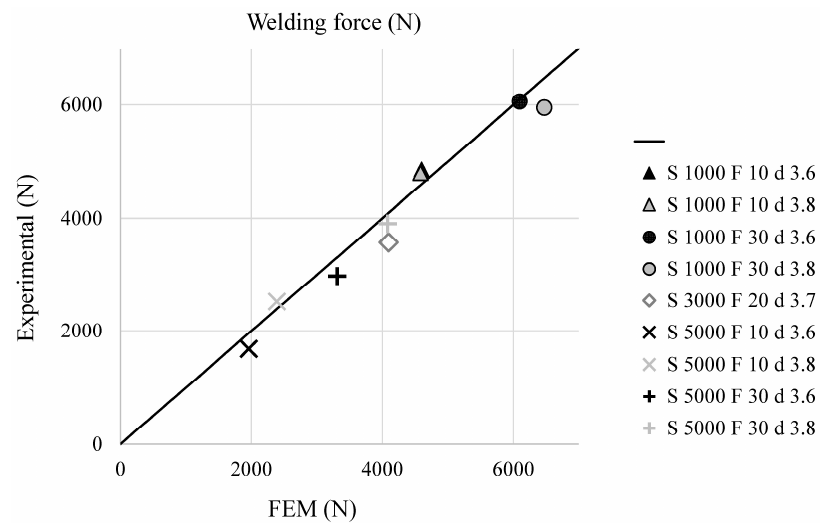
Figure 12. Comparison between experimental and simulated axial welding force for the different welding conditions.